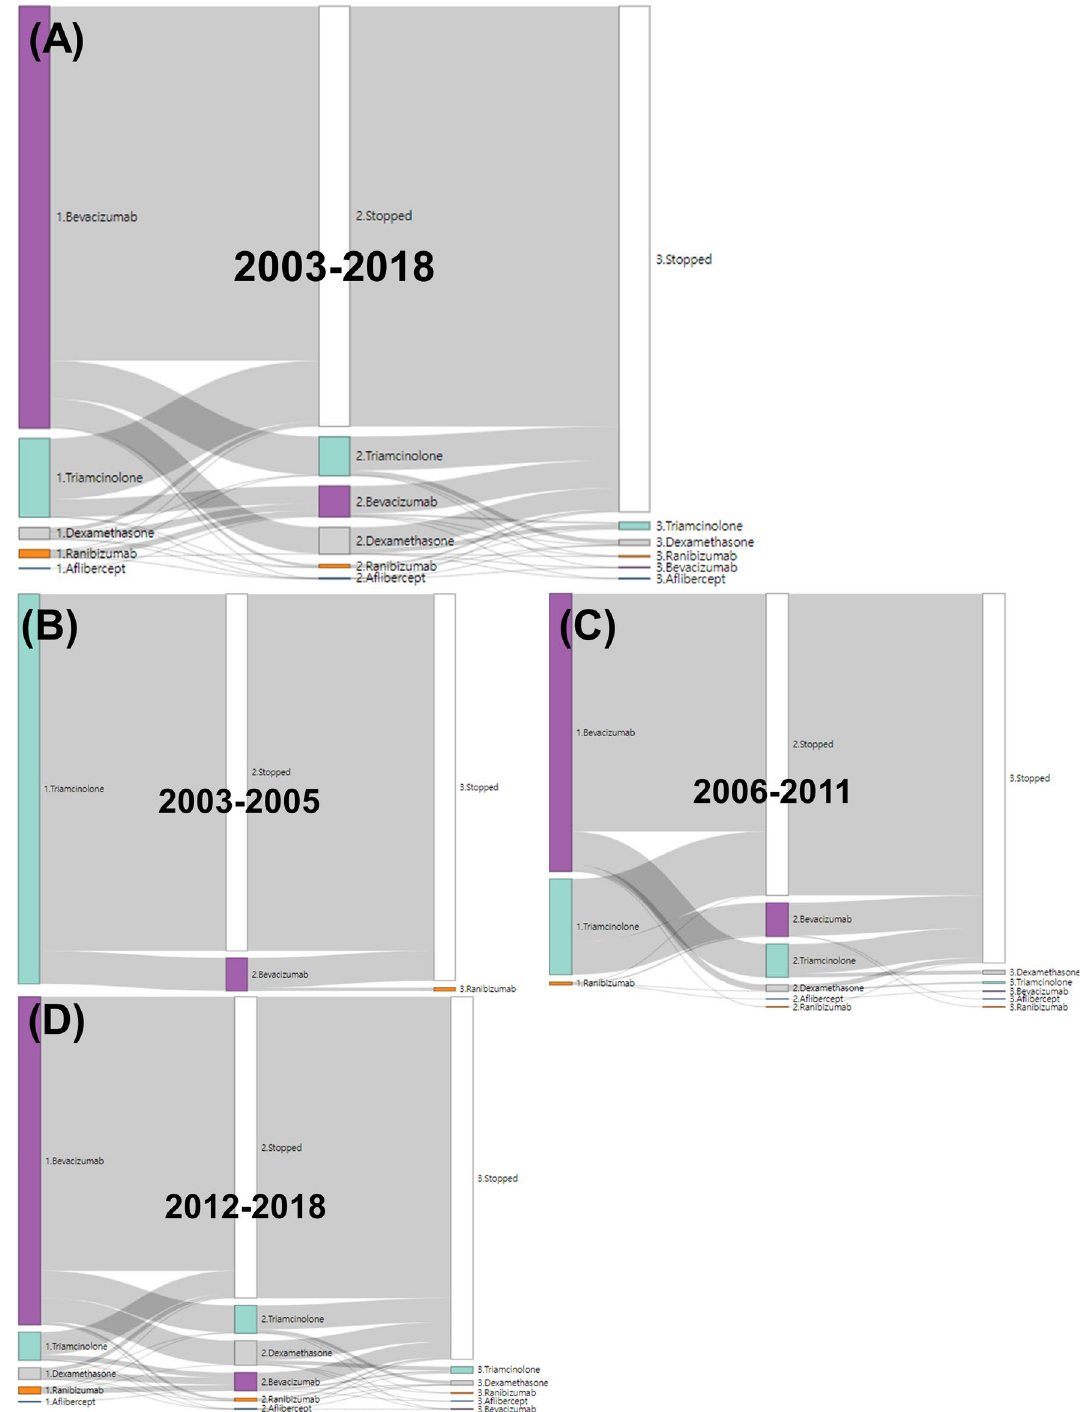
Figure 4. Sankey diagrams of treatment pathways for macular edema following retinal vein occlusion. ( A ) Entire period. ( B ) January 2003–December 2005, ( C ) January 2006–December 2011, ( D ) January 2012– December 2018. R (version 3.6.3, https:// cran.r- proje ct. org) and networkD3 package (version 0.4, https:// cran.r- proje ct. org/ web/ packa ges/ netwo rkD3/ index. html) are used to generate this